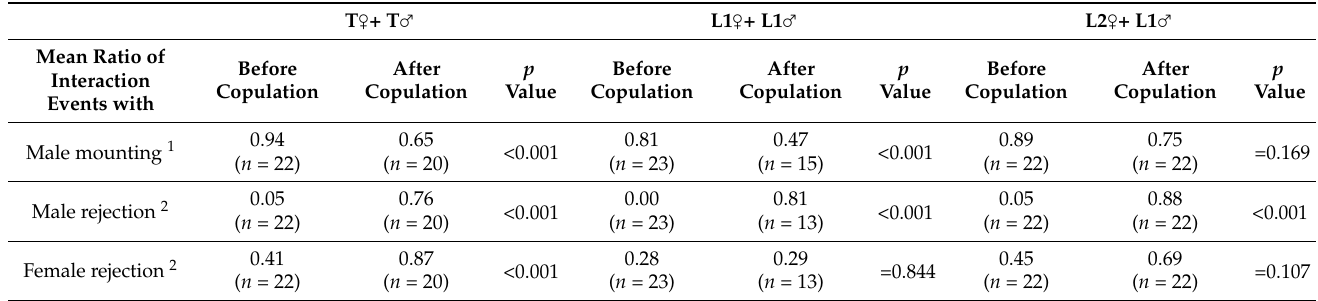
Table 12. The mean ratio of interaction events with male mounting, male rejection and female rejection, analysed before and after copulation.